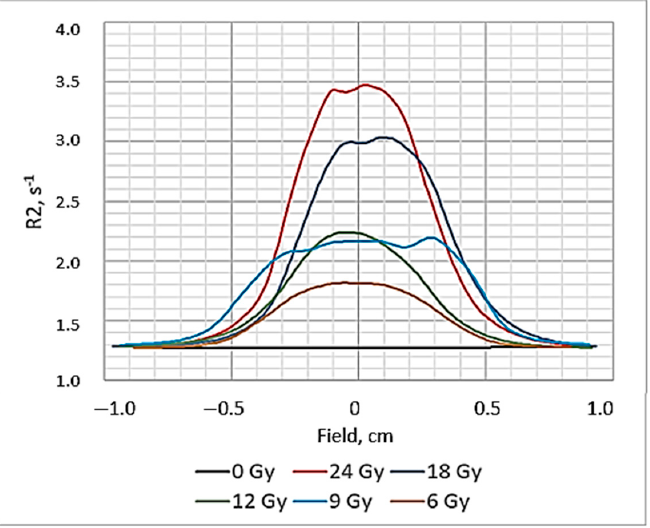
Figure 8. Dose profiles of irradiated gels evaluated by MRI 56 h post-irradiation .